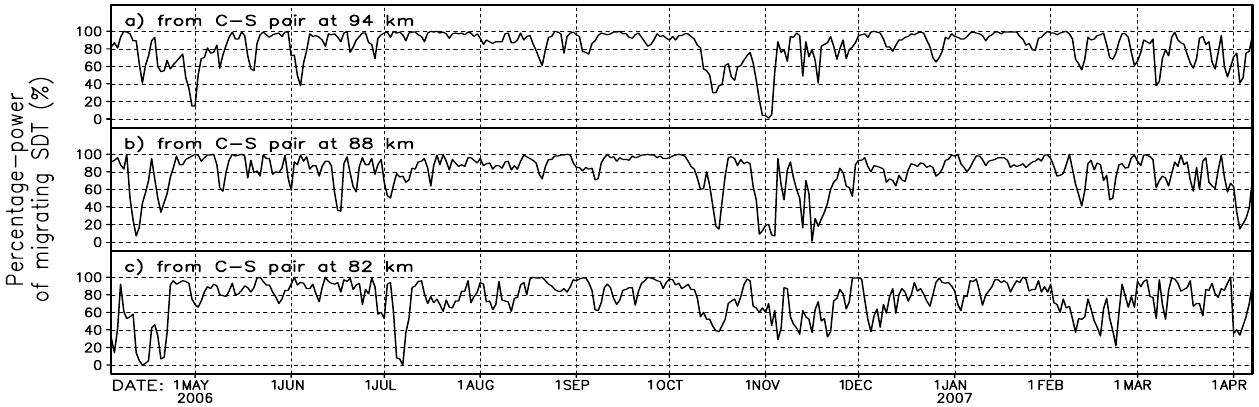
Fig. 5. Time sequences of the percentage-power in the migrating SDT derived from the Collm-Saskatoon pair during 2006/2007.